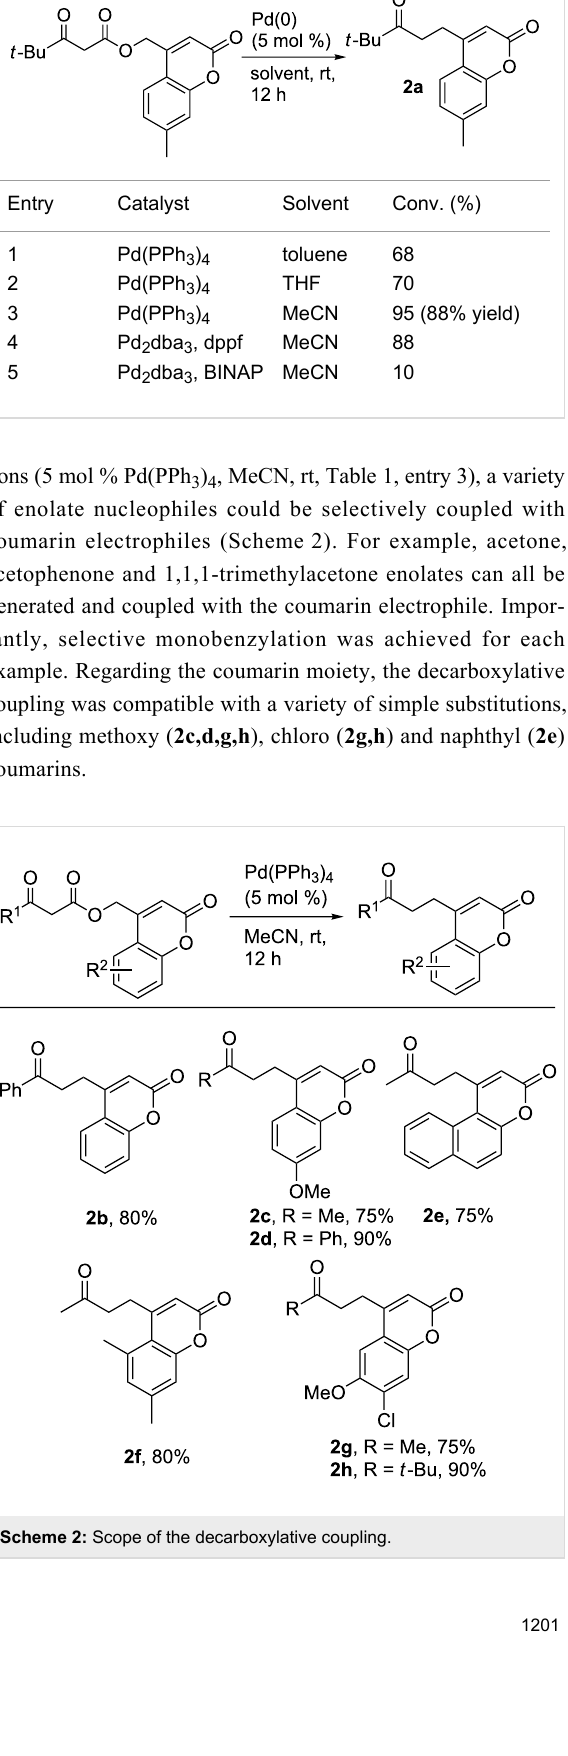
Table 1: Reaction development for the coupling of in situ generated enolates and coumarin π -benzyl complexes.